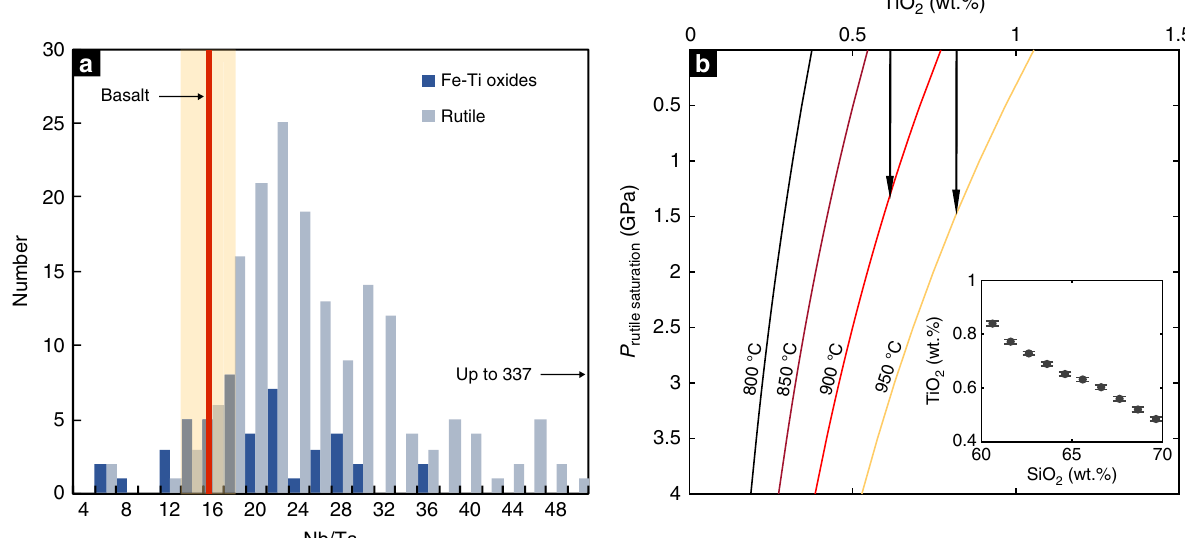
Fig. 3 Nb/Ta ratio distributions in arclogite rutiles and Fe – Ti oxides and pressure – temperature effects on rutile solubility in differentiated silicate melts. a Similar to Fig. 2, the red line shows the average Nb/Ta ratio of global arc basalts (orange band shows the one standard deviation (1 σ )). b Calculated rutile saturation pressure as a function of magma TiO 2 content ( x -axis) and temperature (contours). In the rutile solubility calculation, we assumed a water content of 6 wt.%. We used a minimum magma composition parameter (FM, Ryerson and Watson 28 ) value of 3 for silicate melts with 60 − 65 wt.% SiO 2 . A higher FM value would require an even greater pressure to saturate rutile (Methods). Inset shows the average TiO 2 content as a function of SiO 2 content in arc magmas. Error bars are 2 standard